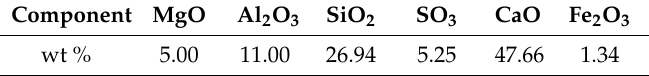
Table 1. Major chemical components of the CPC binder.